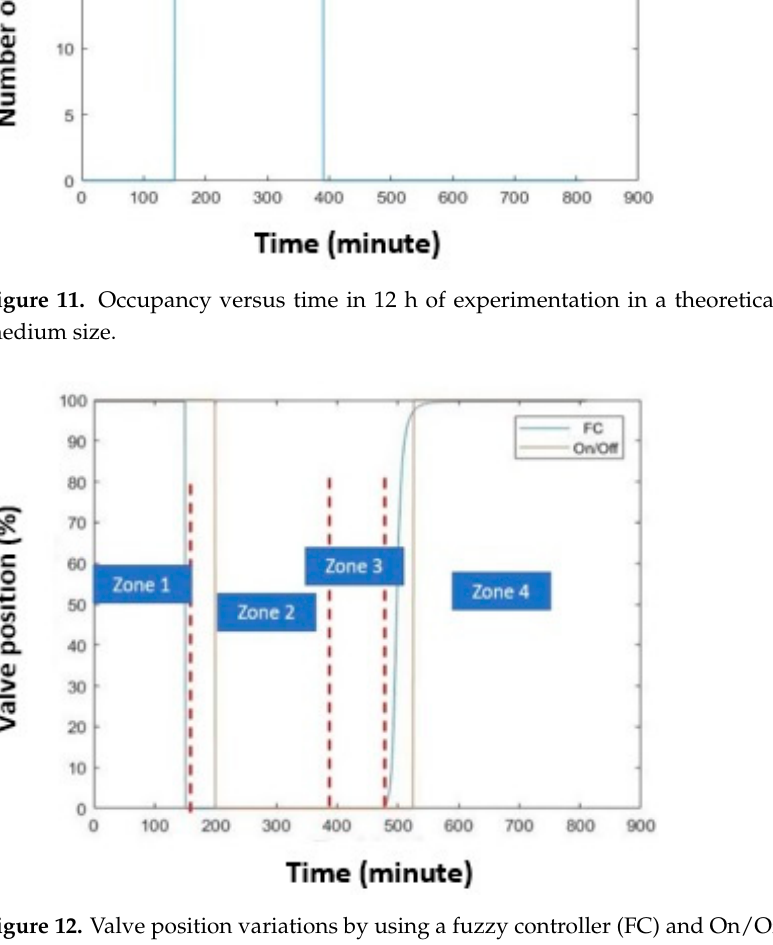
Figure 13. Temperature evolution in a theoretical classroom with a medium size by using a FC and On/Off controller. Zone: It remarks different conditions during the experiments. The initial indoor temperature is 17 °C. In zone 1, while the room is empty, both con- trollers let the motor valve open the valve position to 100% (radiator works at nominal power). After two-and-a-half hours, the indoor temperature in both cases is 18.5 °C. When the room is occupied (zone 2) by 28 people, the FC changes its functionalities, and the